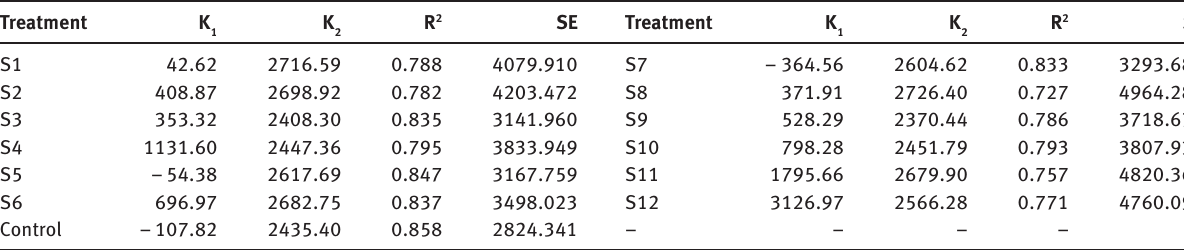
Table 8: Coefficients of the Temkin sorption isotherm, R 2 , and SE for the Cd sorptions of different treatments. Treatment